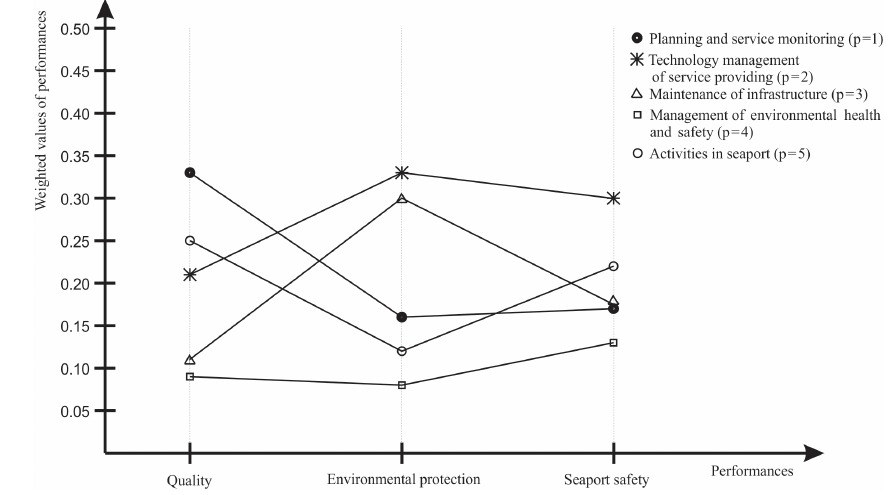
Figure 3. Sensitivity of each business process with respect to the